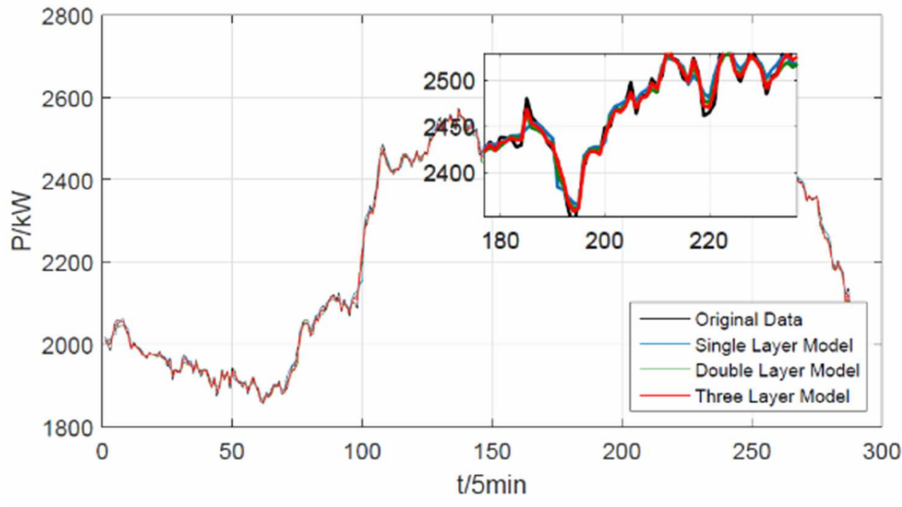
Figure 6. The load forecasting of different layers of